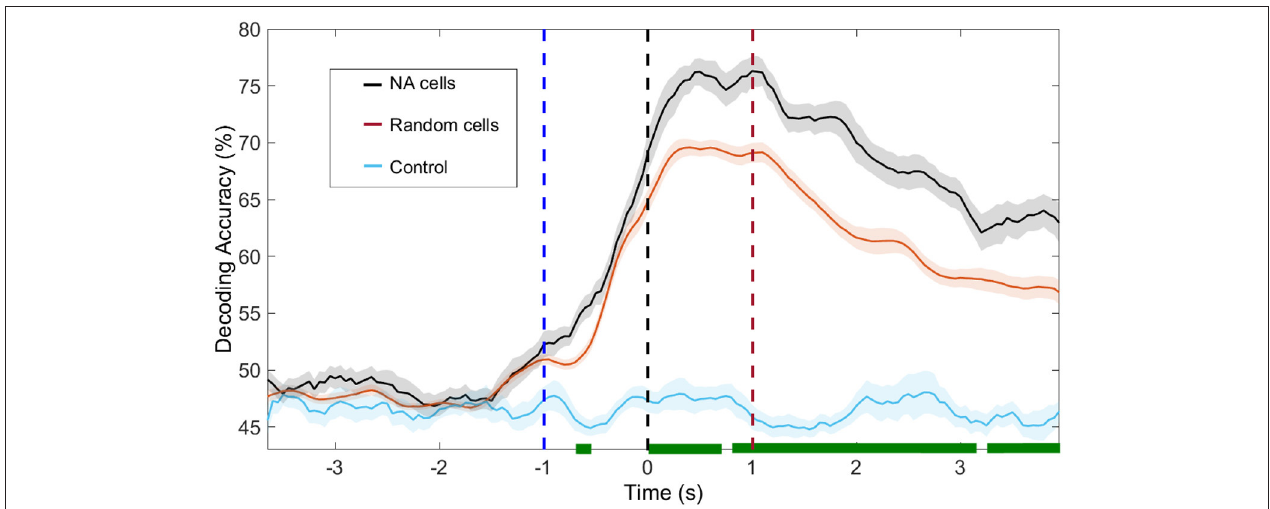
FIGURE 7 | Decoding accuracy of NAs and random neurons. In black, we show the decoding accuracy using solely neurons from the NAs identified with ICA; in blue, the same cells were used but labels of animal response (left/right) are shuffled. In red, we use a random group of neurons out of the total population, containing the same number of cells as the identified NAs. We recall that no further restriction is imposed, i.e., the selection of cells belonging to other NAs, which also significantly modulate their firing rate, is possible. The shuffling process was repeated 100 times. In green, we depict the moments in which the decoding accuracy in NA and random cells are significantly different ( p < 0.05). Time t 0 s marks the moment rats reach the NP. Dashed blue (red) vertical lines indicate the approximate = beginning of trials (reward)